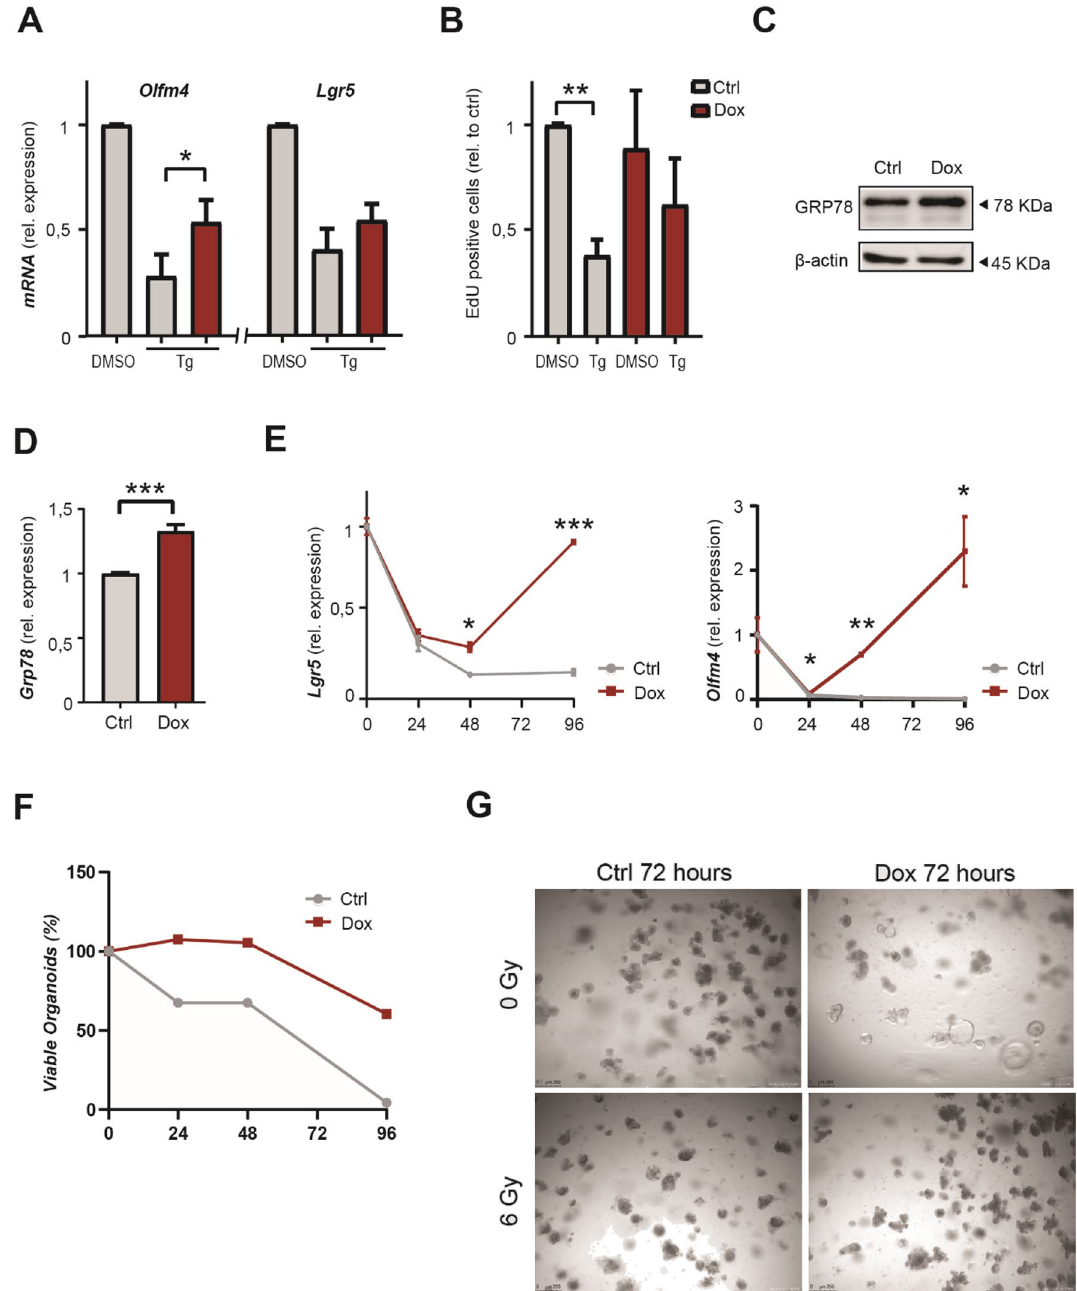
Figure 4. High levels of CtBP2 protect epithelial stem cells against ER stress and gamma irradiation. ( A ) RT-qPCR of stem cell markers in induced CAG-rtTA- CtBP2 organoids after 6 h of DMSO or thapsigargin treatment (n = 2). ( B ) EdU incorporation in induced CAG-rtTA- CtBP2 organoids 6 h after thapsigargin treatment (n = 3). ( C ) Western blot of GRP78 expression upon induction of CtBP2 overexpression. Full-length blots/gels are presented in Supplementary Immunoblotting Data Figure 5. ( D ) RT-qPCR of Grp78 upon induction of CtBP2 overexpression (n = 3). ( E ) RT-qPCR of stem cell markers induced CAG-rtTA- CtBP2 organoids during a time course following 6 Gy of irradiation (n = 3). ( F ) Quantification of viable organoids after 6 Gy irradiation (n = 2). ( G ) Representative images of the phenotype of induced CAG-rtTA- CtBP2 organoids that were irradiated 72 h ago with 6 Gy (n = 3). Images of organoids were captured with a Leica DM6000 microscope using LAS AF software (Leica, Wetzlar, Germany). All western blot images were generated and exported using ImageQuant LAS 4000 software and cropped and labeled using Adobe Illustrator software version 25.2. Graph bars show mean and s.e.m. * P < 0.05, ** P < 0.01, *** P < 0.001, (Student’s t -test or one-way